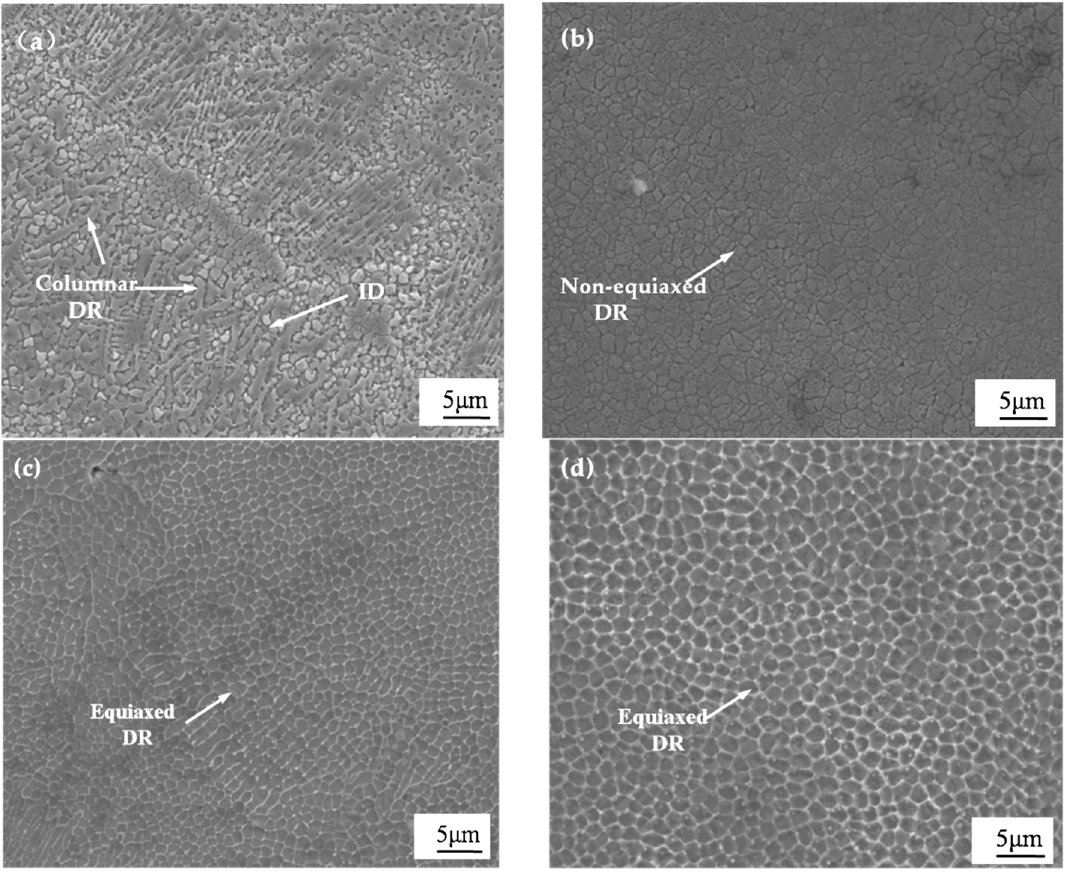
Figure 5. SEM (scanning electron microscopy) images of the as-laser cladding Al x CoCrFeNiTi 0.5 HEA coatings: ( a ) Al 1.0 ; ( b ) Al 1.5 ; ( c ) Al 2.0 ; and ( d ) Al 2.5 .